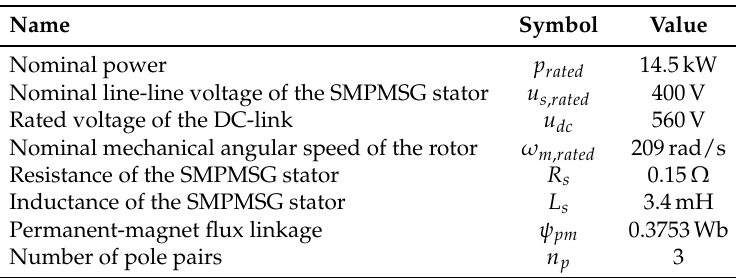
Figure 5. Laboratory setup utilized to validate the presented MRAS-FS observer. Table 1. SMPMSG